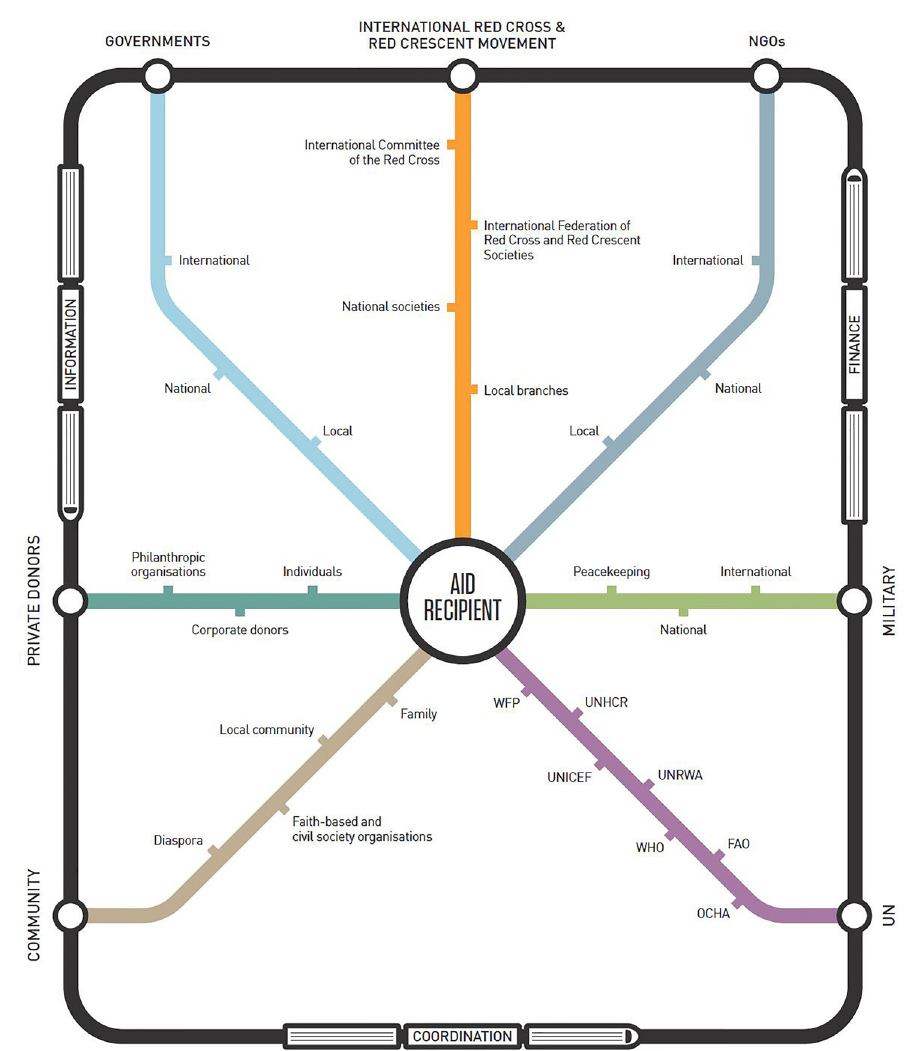
Figure 1. Components of the humanitarian aid network, including international organizations, non-governmental organizations (NGOs), private donors, military actors, and community members: An overview of the ways in which these components interact.